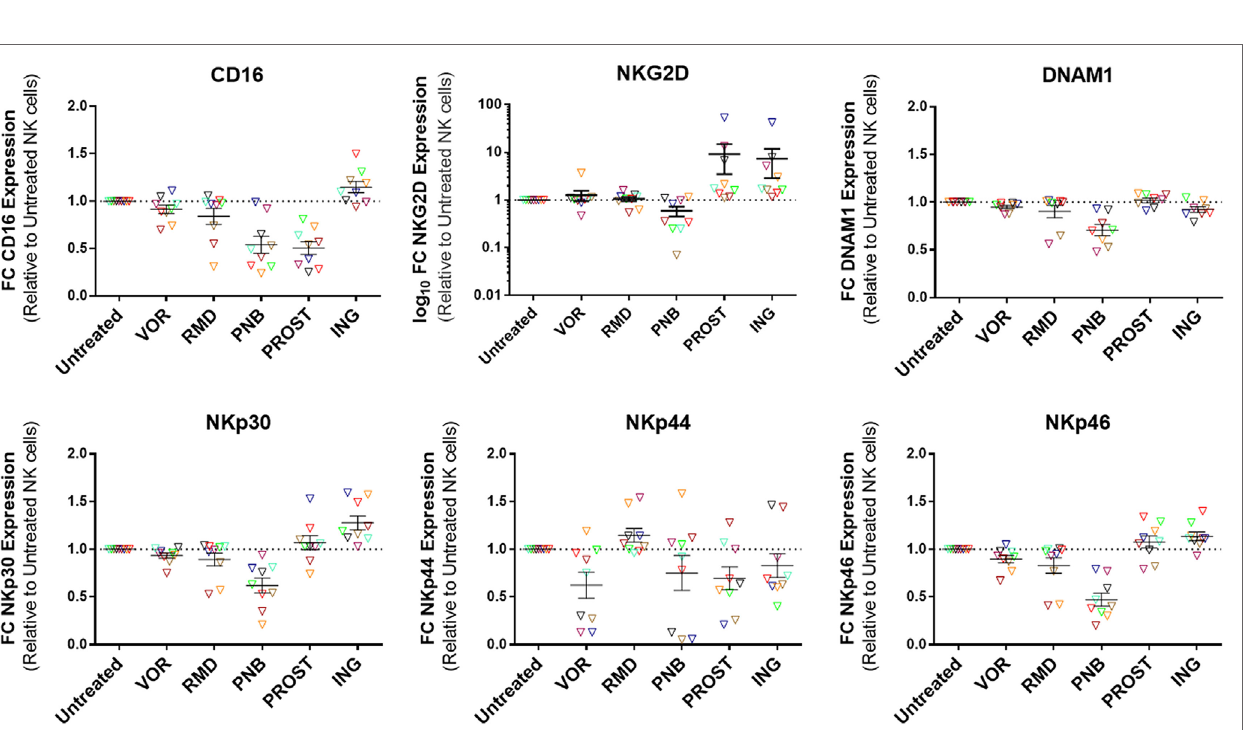
FigUre 5 | non-specific activation of nK cells . Expression of activation markers on NK cells in the absence of target cells or any other stimuli. Graphs represent log 10 of the fold change relative to untreated NKs and each color represents cells from a different donor. (a) Expression of CD69. (B) Expression of CD107a. Exposure to all drugs caused some unspecific activation as measured by CD69 expression, but exposure to the PKC agonists were the most remarkable. PROST also caused a significant increase in CD107a expression. N = 8.